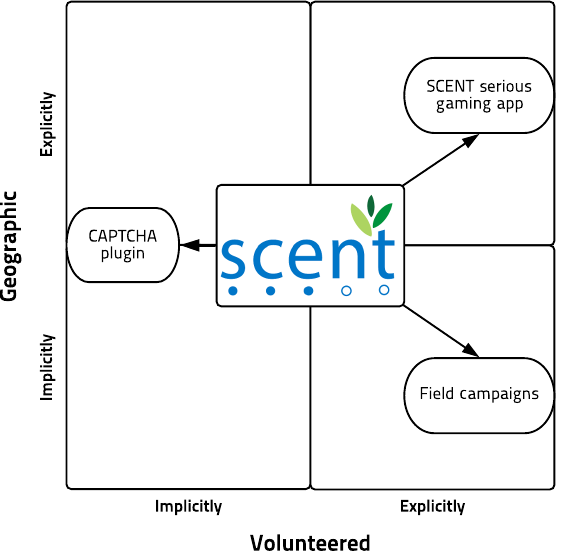
Figure 2. SCENT project represented in the typology of VGI (vol- unteered geographic